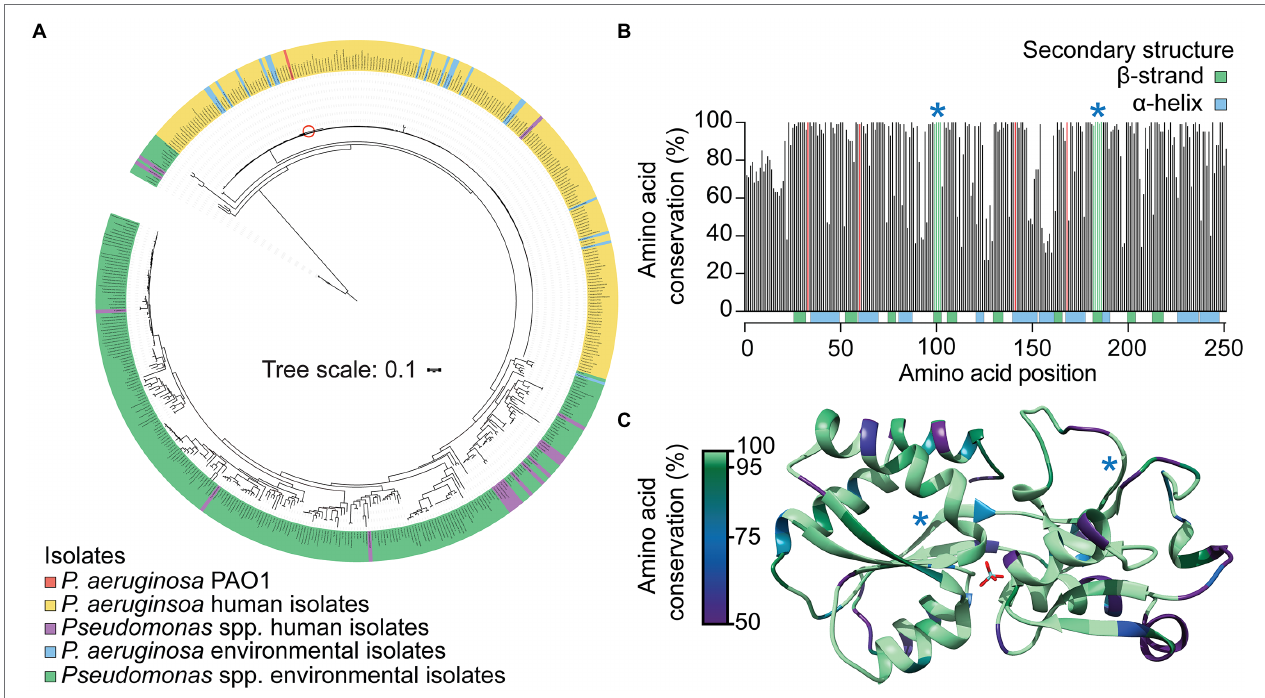
FIGURE 4 | Conservation of ModA in Pseudomonas species. (A) Phylogenetic analysis of modA nucleotide sequences from 522 publicly available Pseudomonas spp. genomes. Environmental and human isolates are as indicated and PAO1 indicated by a red circle. The translated ModA sequences were used to: (B) determine the frequency of amino acid conservation at each position within the protein; and (C) map conservation to the tertiary structure of P. aeruginosa MoO-bound ModA. Metal-coordinating residues are indicated by red bars (B) and conserved β -strands are indicated by green bars and blue asterisks (B) or blue asterisks (C)